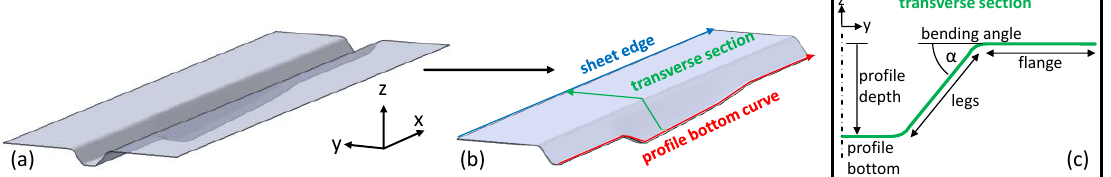
Figure 1. Characteristics and nomenclature of the target geometry.